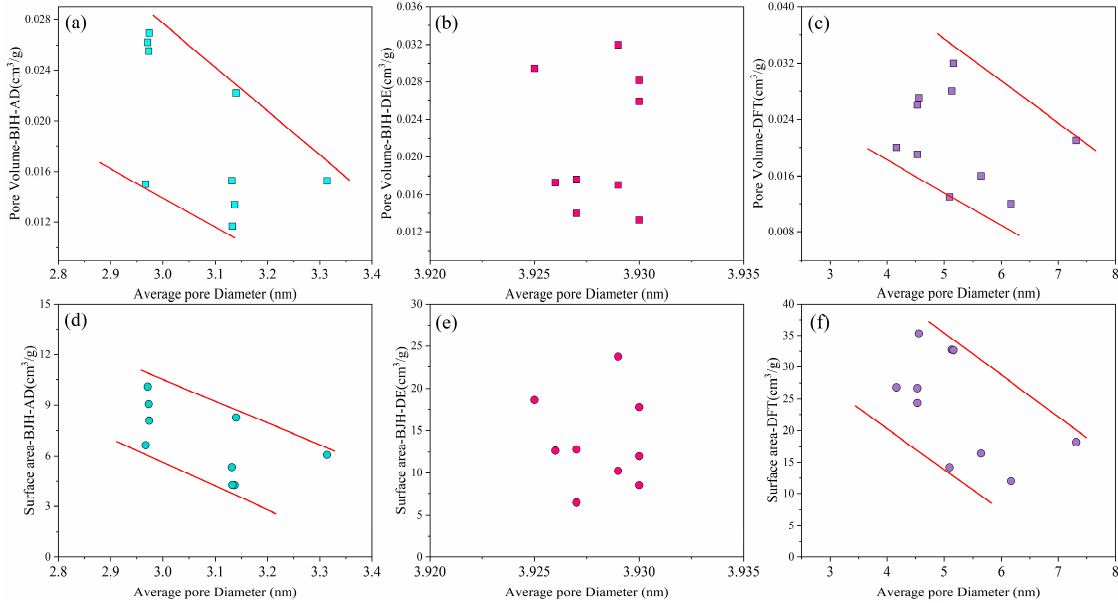
Figure 12. The correlation of ( a – c ) pore volume and ( d – f ) surface area on the average pore diameter of different BJH and DFT models.